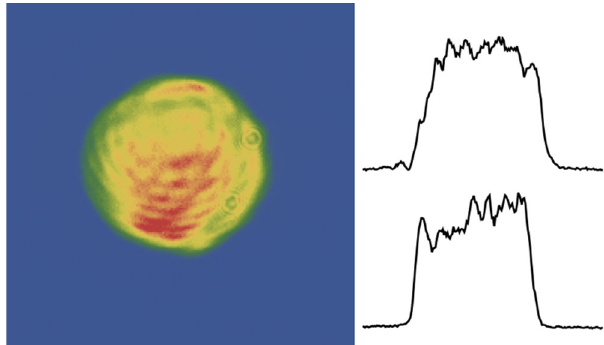
FIG. 6. Laser profile taken on virtual cathode for 0.5 mm diameter pinhole aperture used for ∼ 40 (cid:1) 2 pC operation with 3 . 5 (cid:1) 0 . 2 μ J energy for a quantum efficiency of 5 × 10 − 5 . Horizontal and vertical lineouts for image.